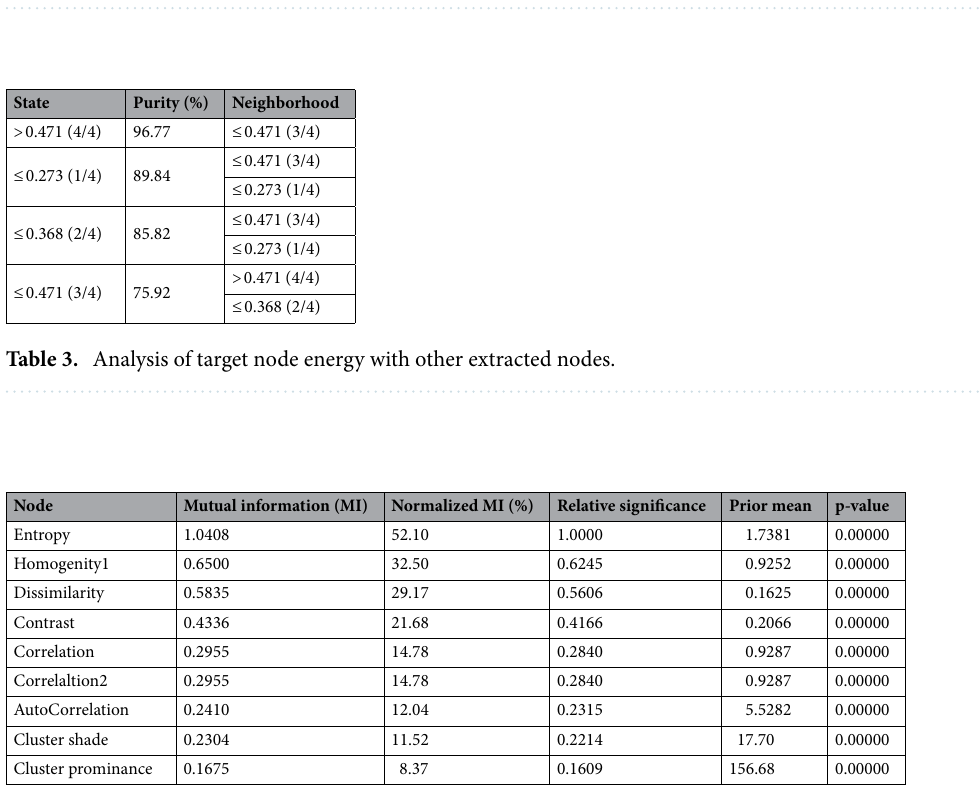
Figure 5. Analysis of target node energy with other extracted nodes using mosaic graph based on selected target node energy and predictions of occurrence made against each state out of total (i.e. ≤ 0.273, 354/394; ≤ 0.368, 321/374; ≤ 0.471, 143/192; > 0.471, 27/28).